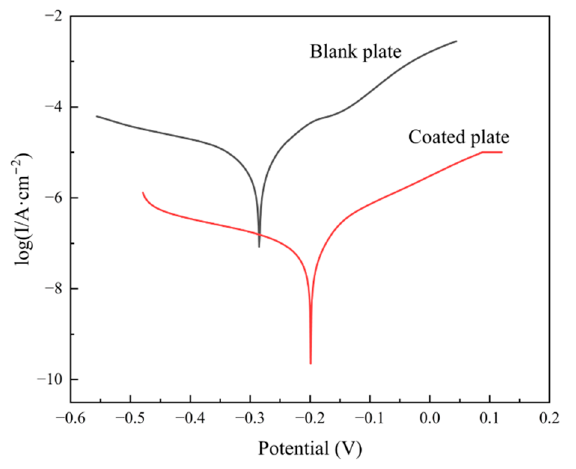
Figure 7. The Tafel polarization curves of the blank plate and coated plate. Table 1. Tafel polarization parameters of the blank plate and coated plate.